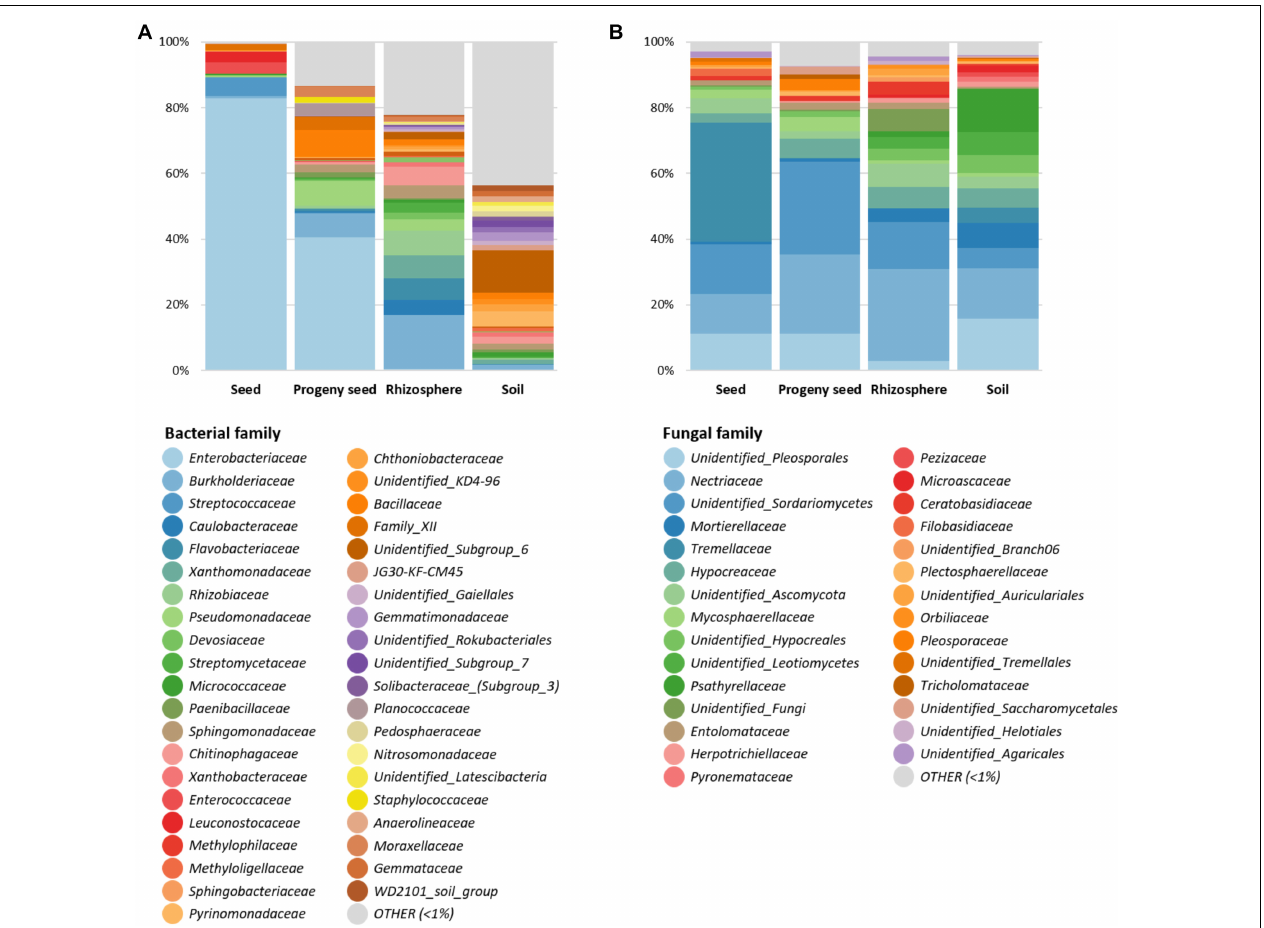
FIGURE 2 | Relative taxonomic composition of four sample types (seed, progeny seed, rhizosphere, and soil). Bacterial (A) and fungal (B) taxa on family level with abundance higher than 1% are shown individually. Low-abundance taxa are summarized as